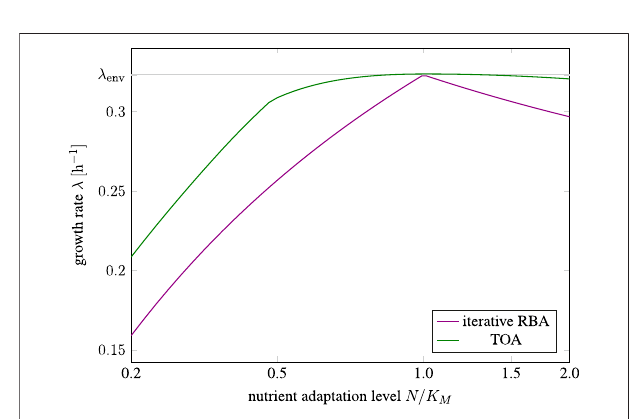
FIGURE 6 | Growth rate of differently adapted cells as predicted by cell- doubling experiments using TOA and iterative RBA in an environment with relative nutrient availability N/K M = 1.0; λ env ≈ 0.32 h − 1 denotes the maximal growth rate as predicted by